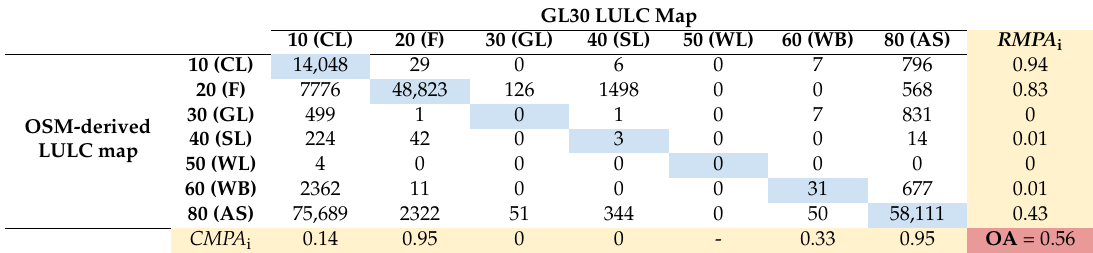
Table 6. Confusion matrix and indices of agreement for the Dar es Salaam study area.